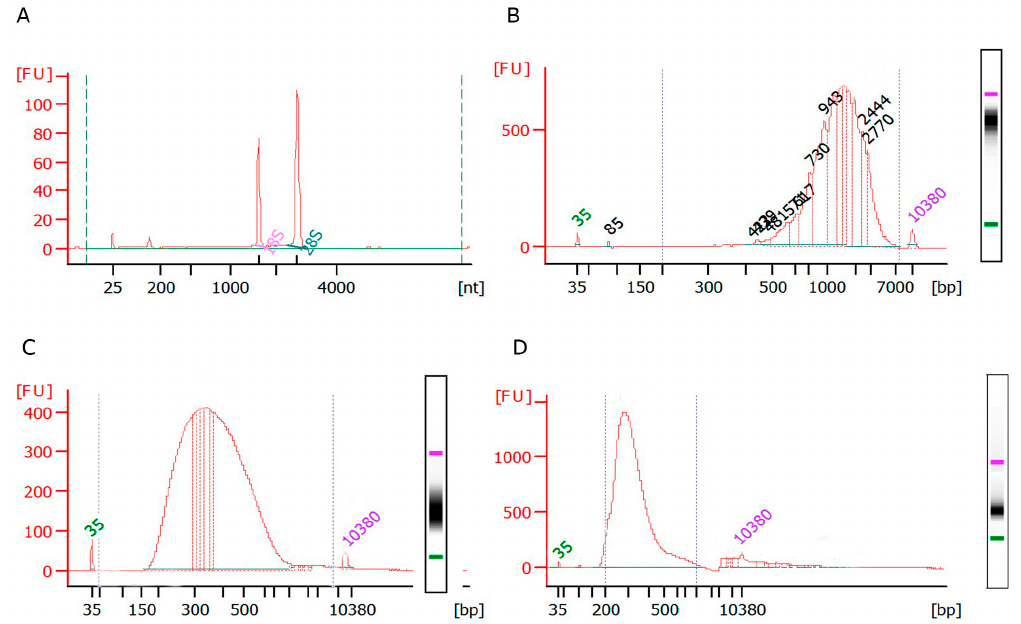
Figure 3. Bioanalyzer analysis of RNA, cDNA, and sequencing libraries generated from GFP- and mCherry-positive protoplasts. ( A ) Electropherogram of an RNA profile extracted from GFP-positive protoplasts (RIN: 9.9, Ratio 28S / 18S: 2). ( B ) Profile of cDNA generated from RNA extracted from GFP-positive protoplasts, showing an average size of 1546 bp. Inset: digital electrophoresis. ( C , D ) Profile of a sequencing library generated from GFP-positive protoplasts, showing an average size of 400 bp ( C ) or from mCherry-positive protoplasts, showing an average size of 300 bp ( D ). Insets: digital electrophoreses. 3. Protocol: Isolation of Fluorescently Marked Arabidopsis Root Protoplasts from Roots Grown under Darkness Conditions Using D-Root.